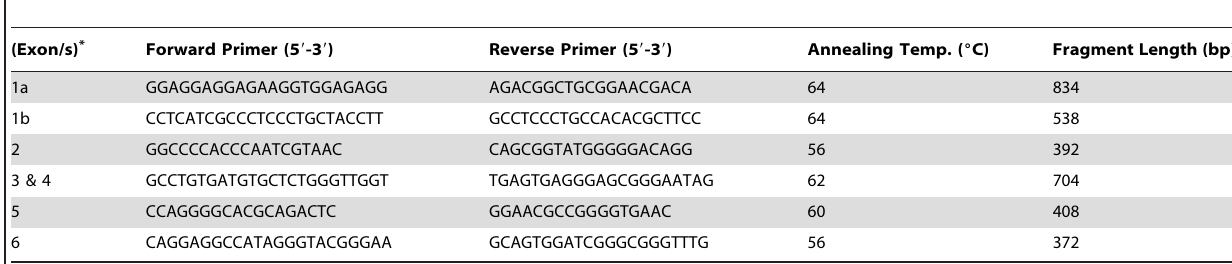
Table 1. Primers and cyclic conditions used for the amplification of the coding and intron-exons boundaries of ABCD1.